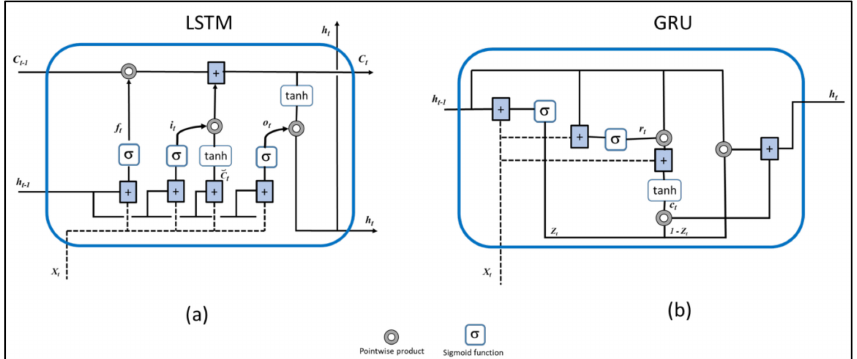
Figure 3. Recurrent neural networks. ( a ) LSTM; ( b )